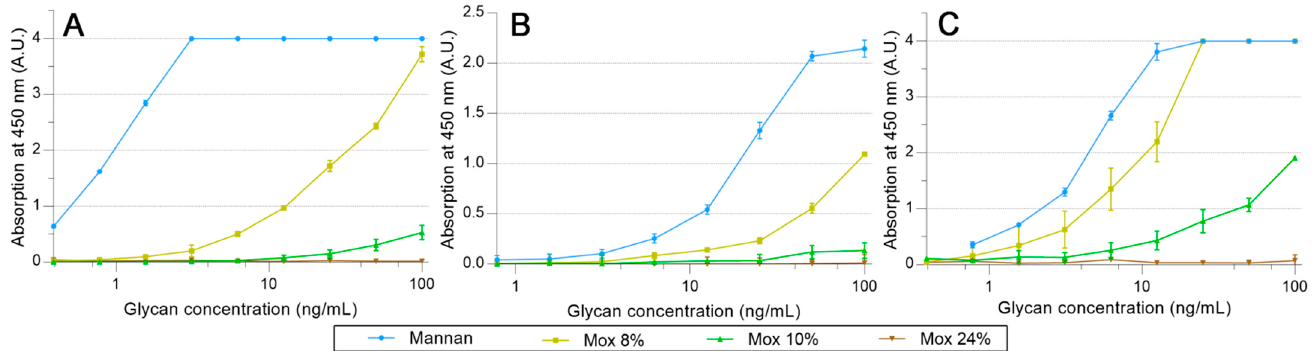
Figure 7. Avidity determination between oxidized mannan and fixed hMBL ( A ), hSP-D ( B ), and pSP-D ( C ). Lectins fixed on magnetic beads are mixed in mannan solutions for 20 min at room temperature. After three washing steps, beads are placed in a solution of hMBL-HRP for 20 min at room temperature. Avidity determination occurs after the oxidation of the TMB solution by washed beads and absorbance reading at 450 nm.